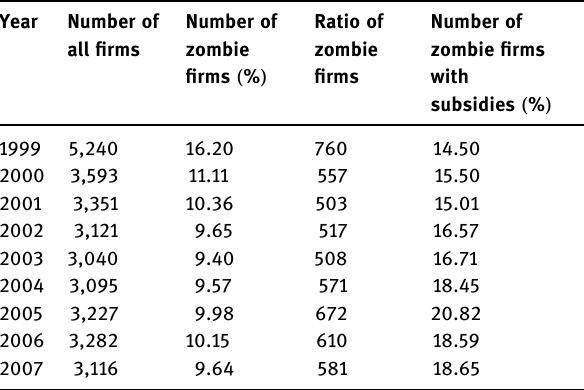
Table 8: Ratio of fi scal subsidies and zombie fi rms prior